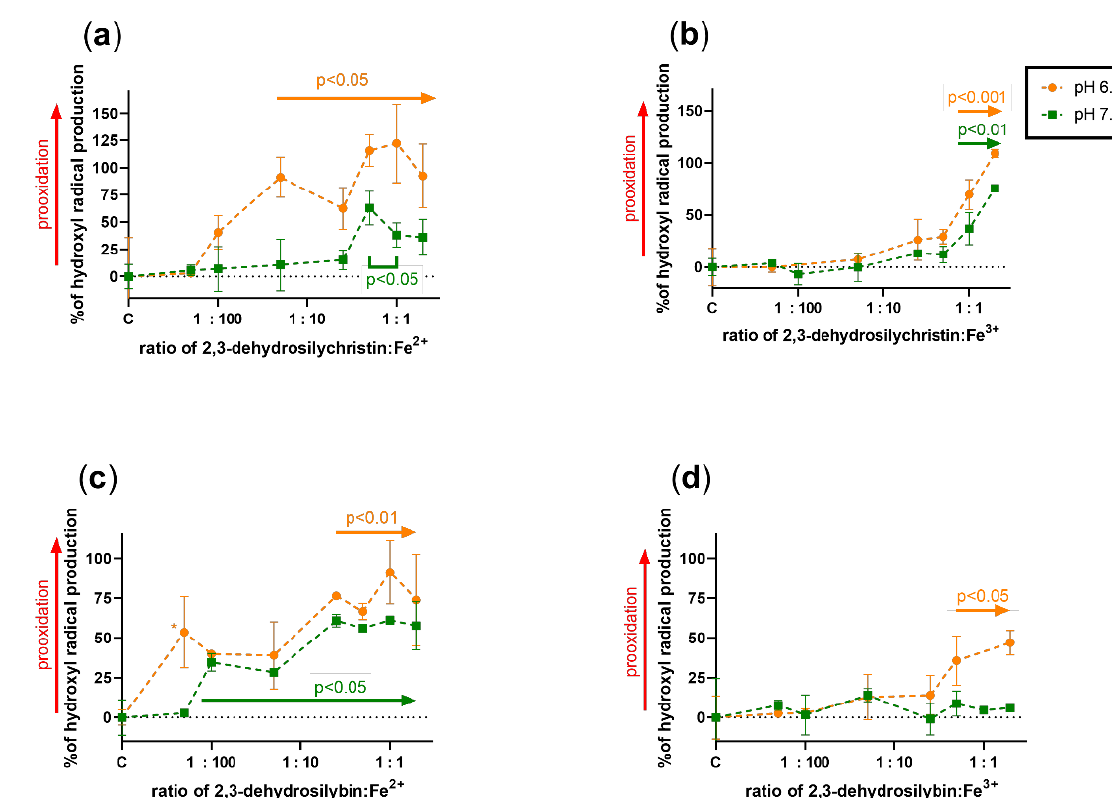
Figure 10. Effect of dehydroflavonolignans on the iron-based Fenton chemistry at pH 6.8 and 7.5: ( a ) 2,3-dehydrosilychristin + Fe 2+ ; ( b ) 2,3-dehydrosilychristin + Fe 3+ ; ( c ) 2,3-dehydrosilybin + Fe 2+ ; ( d ) 2,3-dehydrosilybin + Fe 3+ . Statistical significance vs. the control (C: positive blank—the Fenton reaction with the solvent) is shown directly in the figures.